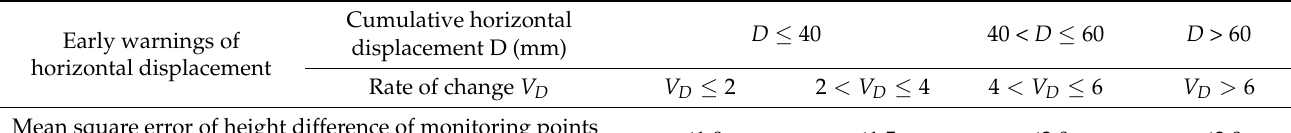
Table 1. Accuracy requirements and threshold for horizontal displacement monitoring.